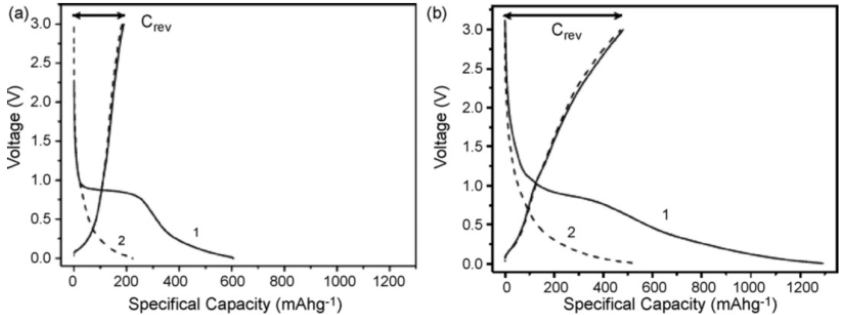
Figure 8. Performances of different CNTs in Li-ion batteries. Discharge/charge curves of Li insertion/extraction into/from conventional ( a ) long; ( b ) short; and ( c ) cut CNTs for the first and second cycles at a current density of 25 mAg − 1 ; and ( d ) charge capacities of long and short CNTs as a function of cycle number. (Reprinted with permission from [67]. Copyright (2009) by